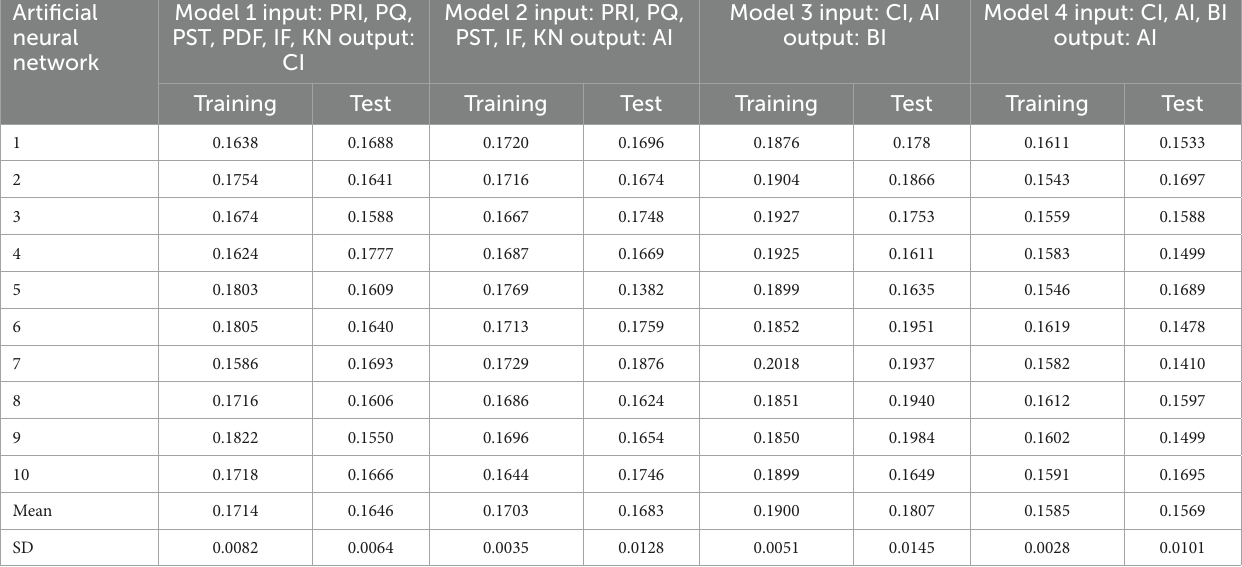
TABLE 8 Root mean square error values for artificial neural networks.